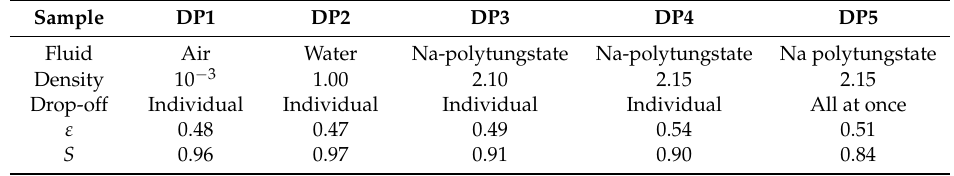
Table 1. Settling conditions (density of fluid and particle drop-off procedure chosen) for disk packing experiments and associated extraction of porosity ε and order parameter S (uncertainty of ±